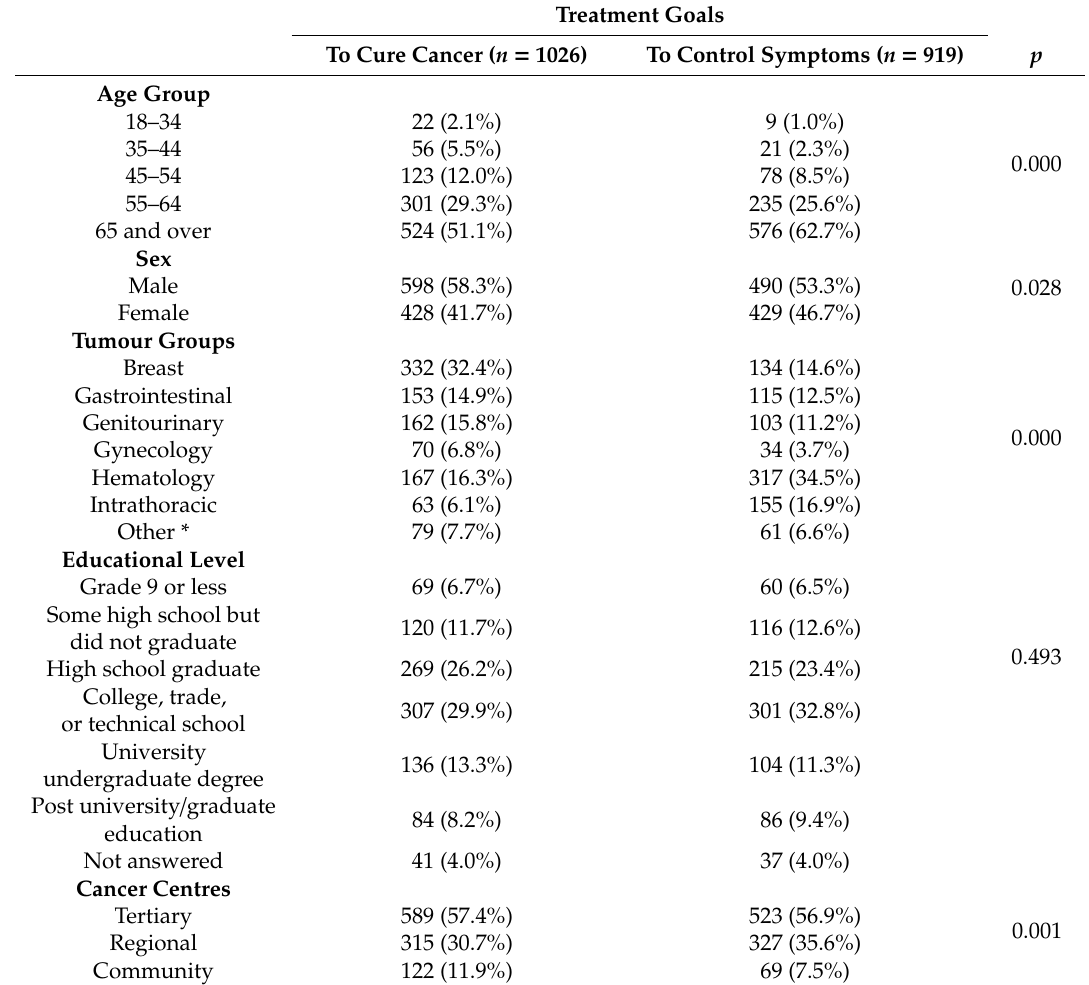
Table 1. Distribution of sociodemographic and disease-specific variables by patient treatment